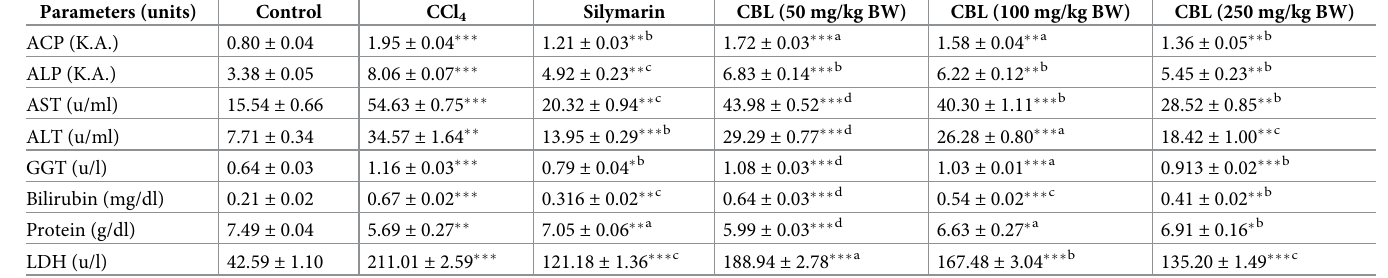
Table 3. Changes in the levels of various enzymatic and biochemical parameters of the culture supernatants of the experimental groups. Data represented as mean ± SD of six observations. Parameters